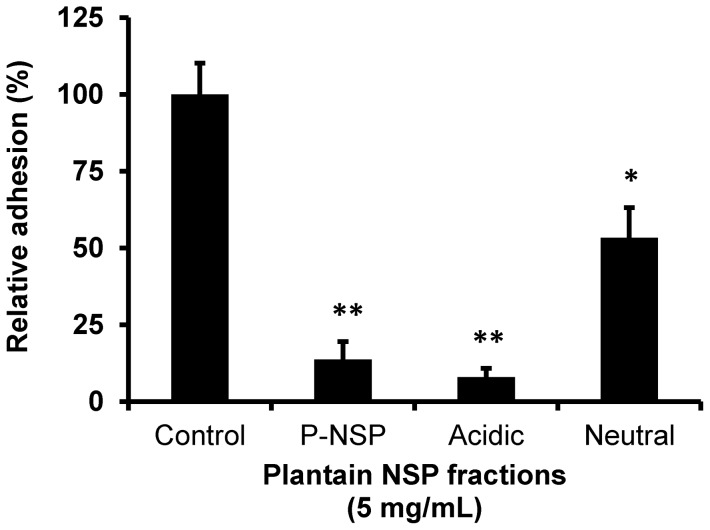
The inhibitory activity of soluble plantain NSP to block Salmonella-host intestinal epithelium interaction lies within an acidic polysaccharide component.At 5/mL, the acidic polysaccharide fraction of plantain NSP significantly blocked adhesion of S. Typhimurium LT2 to human intestinal Caco2 cells, whereas the neutral fraction had a lesser effect compared to vehicle-treated control (N = 2 experiments, n = 3 replicates; * P<0.05, ** P<0.01 Kruskal-Wallis).